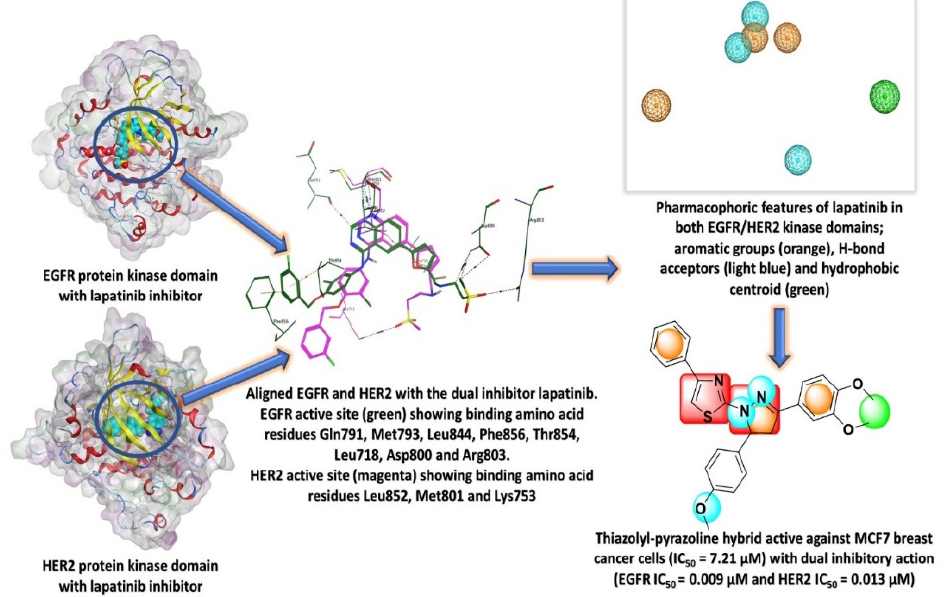
Figure 3. Designed strategy of the thiazolyl–pyrazoline hybrids as dual EGFR/HER2 inhibitors.